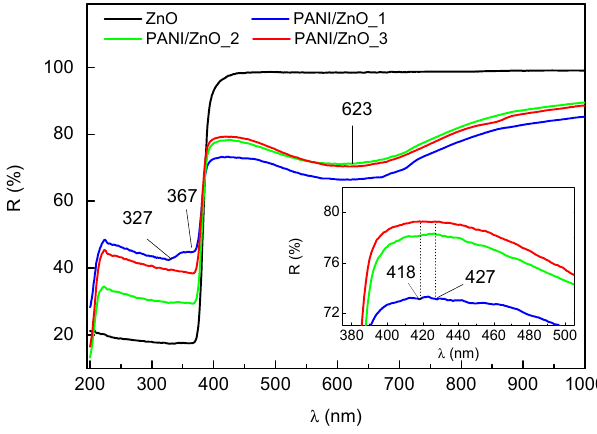
Table 1. ZnO bandgap ( E g ) determined from UV/Vis reflectance spectra of composite photocatalysts.